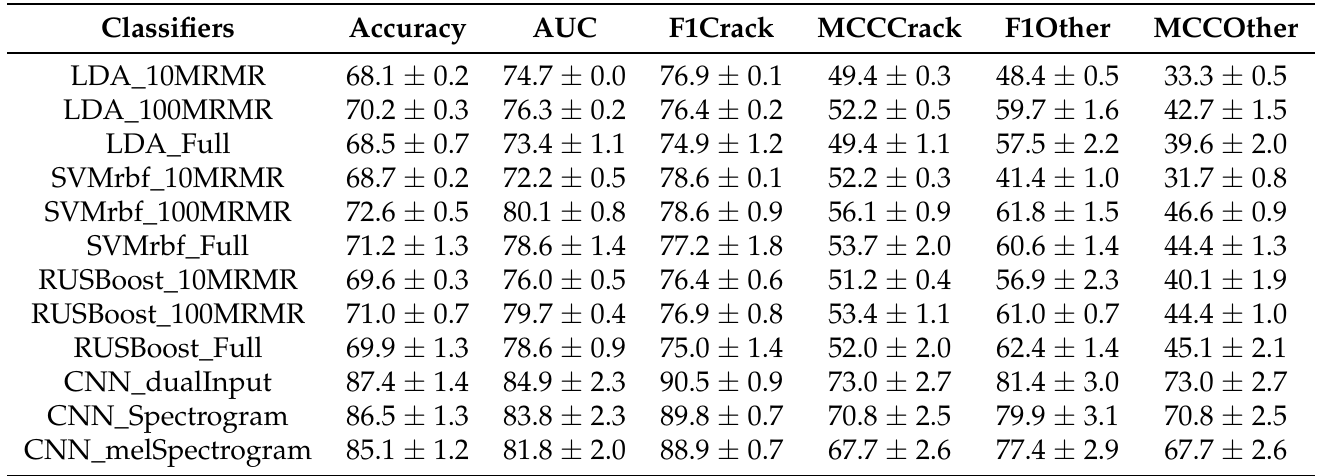
Table 15. Performance results obtained with 2 classes (crackle vs. other)—training: variable duration; testing: variable